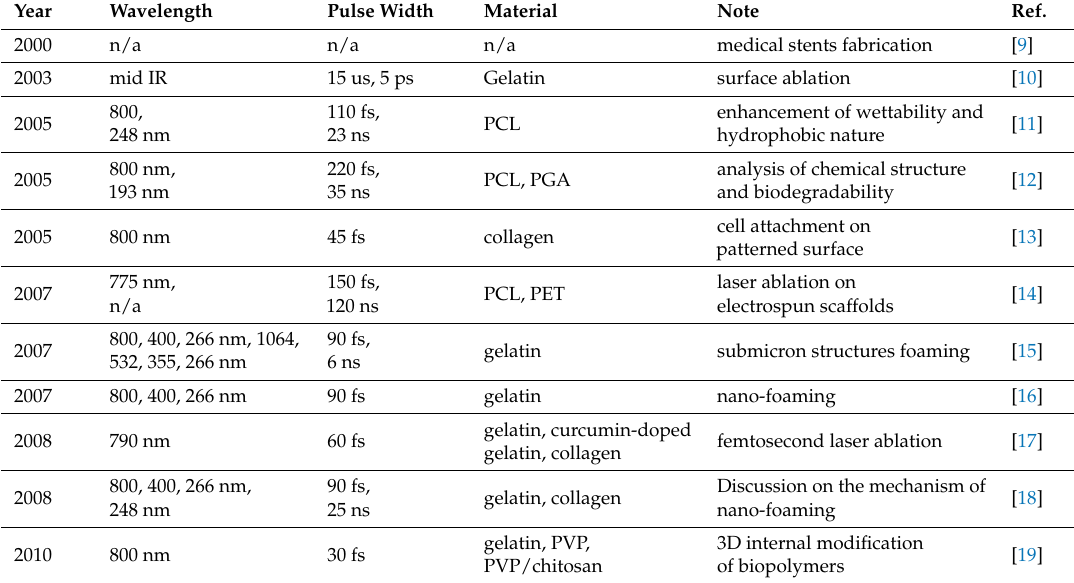
Table 1. Ultrashort pulse laser processing of biodegradable